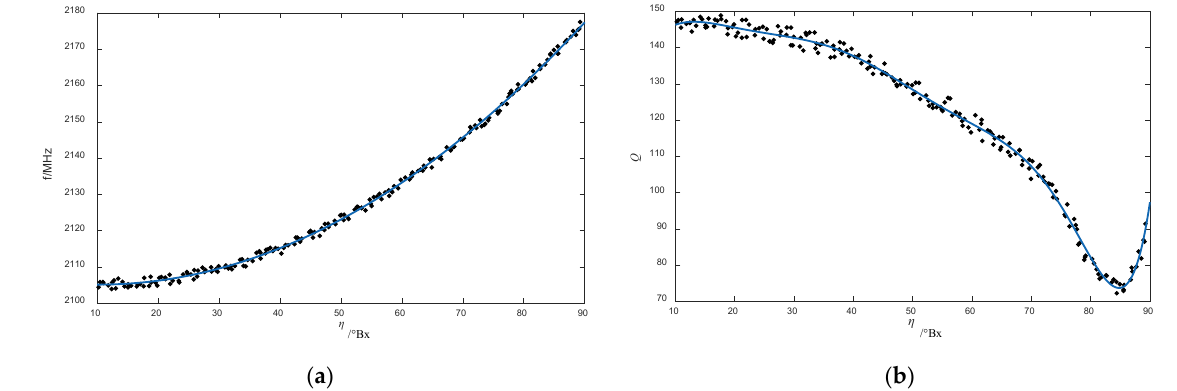
η , and between Q and